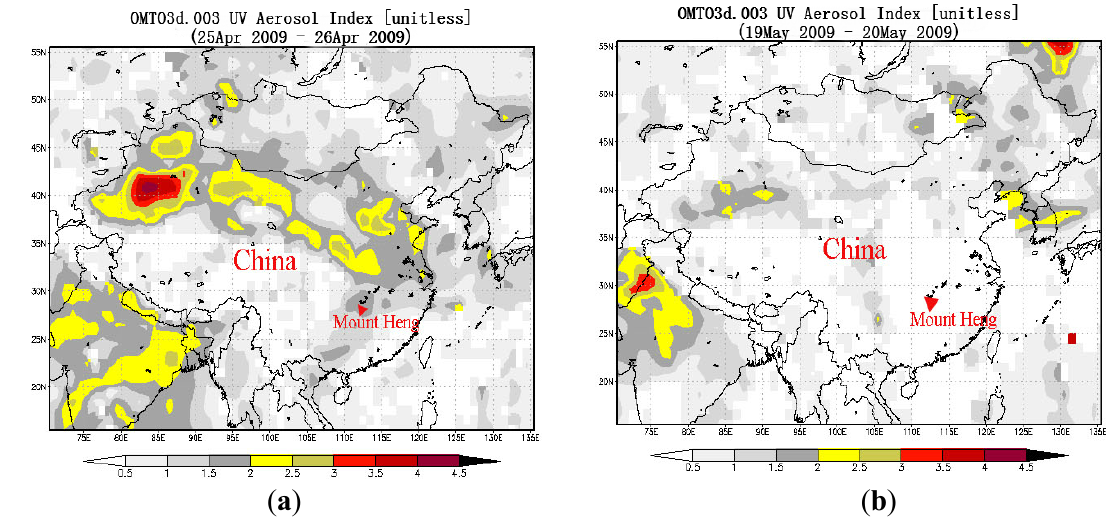
Figure 1. Sampling locations and UV (ultraviolet) aerosol index under normal conditions ( a ) and during the sandstorm ( b